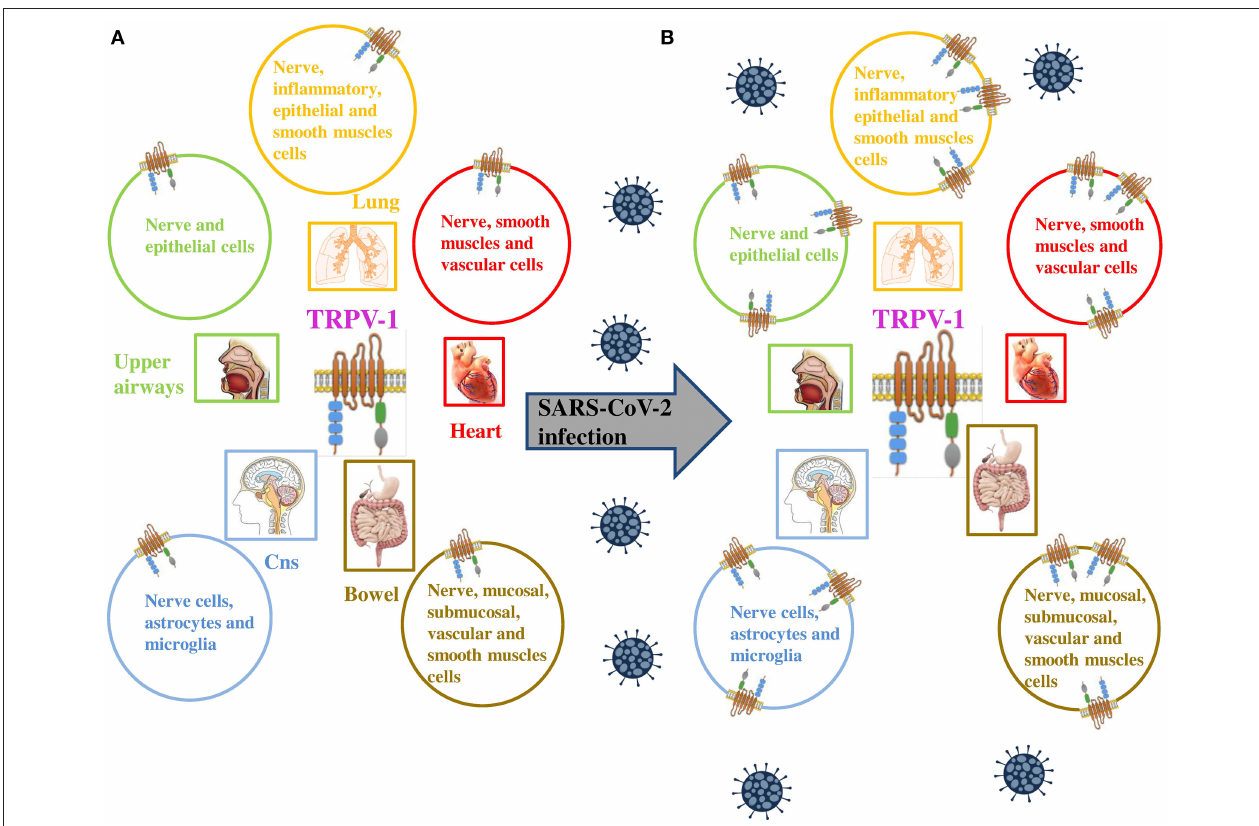
FIGURE 1 | (A) TRPV-1 is extensively expressed on neuronal and non neuronal cell membranes, including immune cells and type C sensory nerve fibers of the airways (upper and lower respiratory tract and lung parenchyma). (B) TRPV-1 has been found to be significantly upregulated in numerous viral infections, similarly SARS-CoV-2 is proposed to upregulate the expression of the channel on neuronal and non neuronal cell membranes of infected patients. Adapted from (